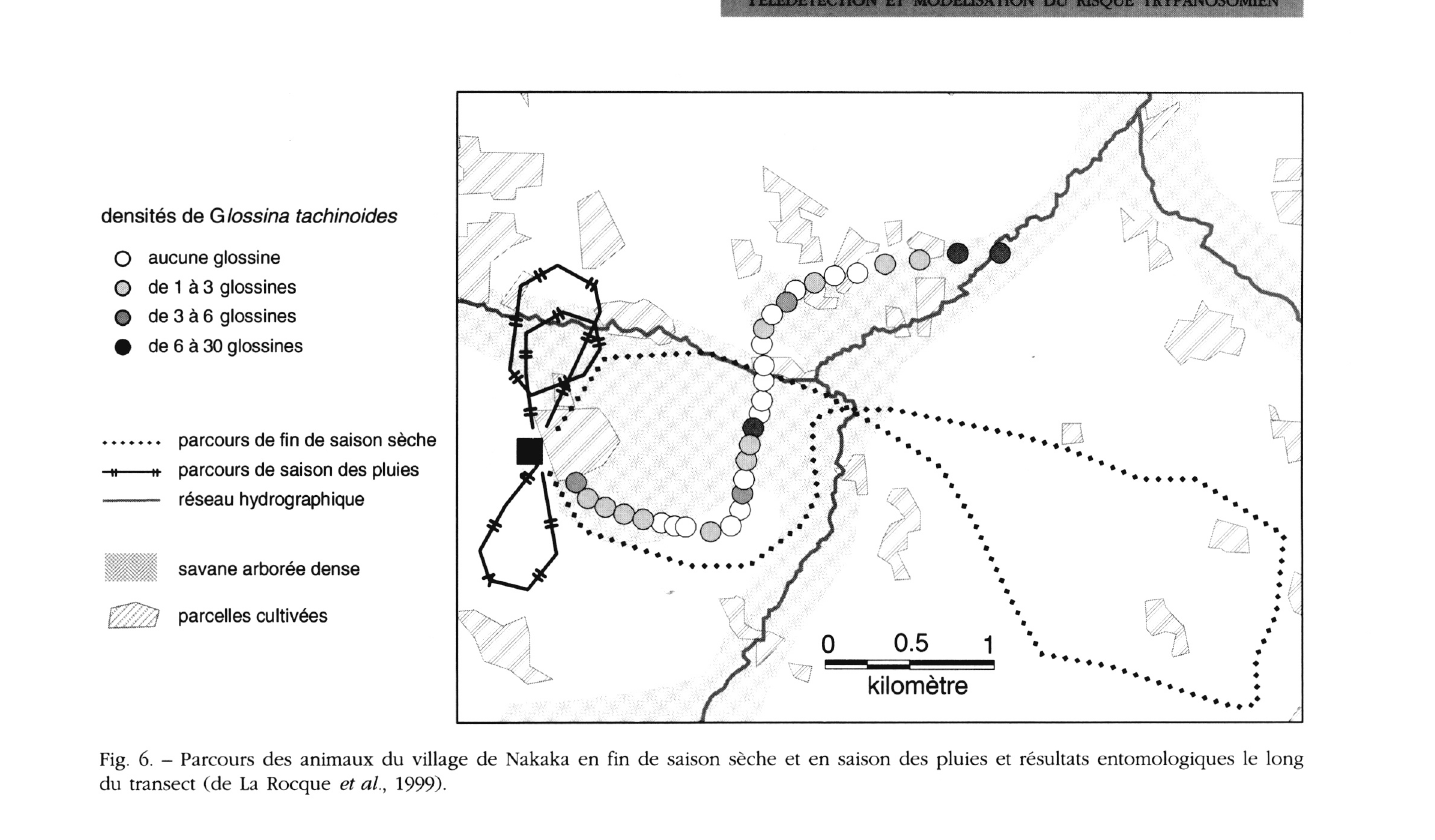
Fig. 6. - Parcours des animaux du village de Nakaka en fin de saison sèche et en saison des pluies et résultats entomologiques le long du transect (de La Rocque et al., 1999).